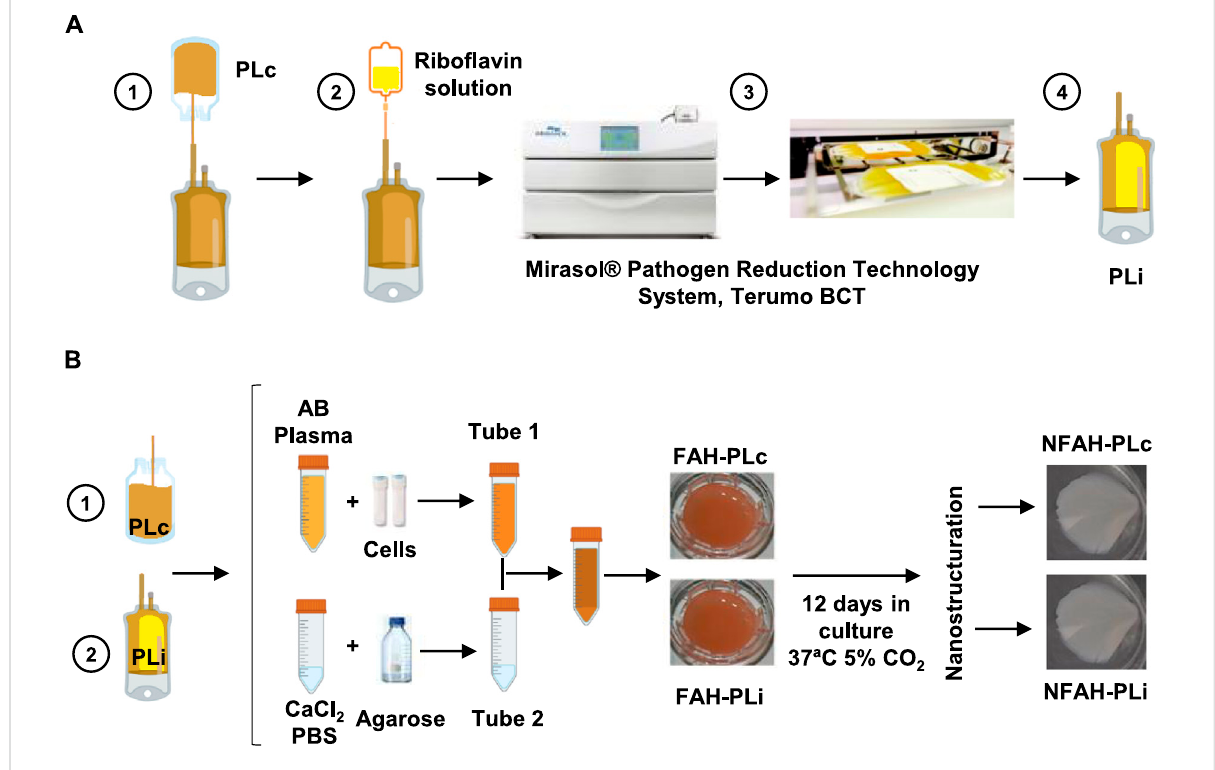
FIGURE 1 Inactivation of human plasma and generation of the cellularized nanostructured fi brin-agarose hydrogel. (A) Schematic representation of human plasma treated with the Mirasol ® Pathogen Reduction Technology System. (B) Experimental design of the generation of nanostructured fi brin-agarose hydrogel with embedded allogeneic dermal fi broblasts with PLc and PLi. PLc, non-inactivated plasma; PLi, inactivated plasma; CaCl calcium chloride; PBS, phosphate buffered saline; FAH, fi brin-agarose hydrogel; NFAH, nanostructured fi brin-agarose